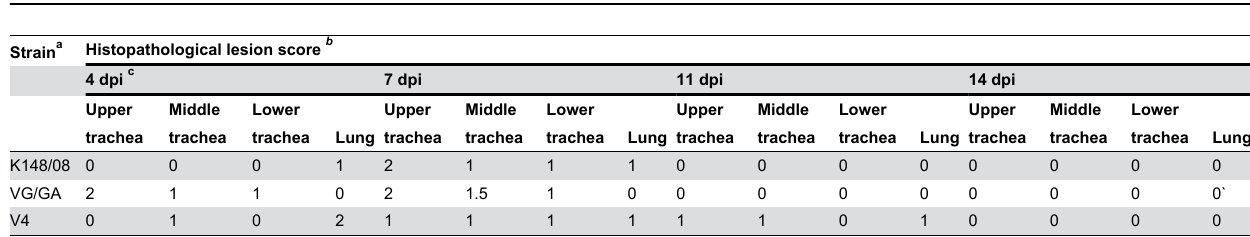
Table 3. Histopathological lesion score in day-old SPF chicks after vaccination using a fine sprayer with the NDV K148/08 strain or commercially available NDV vaccine strains.